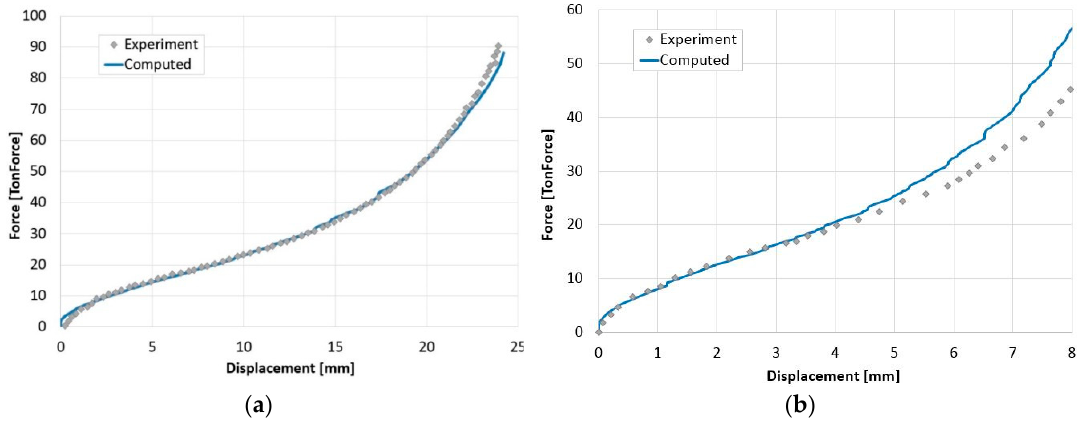
Figure 6. Experimental vs. numerical force-displacement curve for specimen A1, flow stress determined from cylinder upsetting alone ( a ). Experimental vs. numerical force-displacement curve for specimen R1, which has the same experimental conditions ( b ).